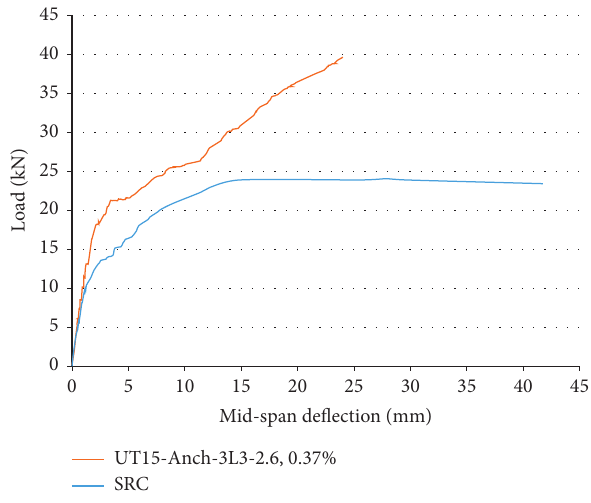
UT15-Anch-3L3-2.6, 0.37% Figure 7: Load-deflection curve of TRC and SRC beams.